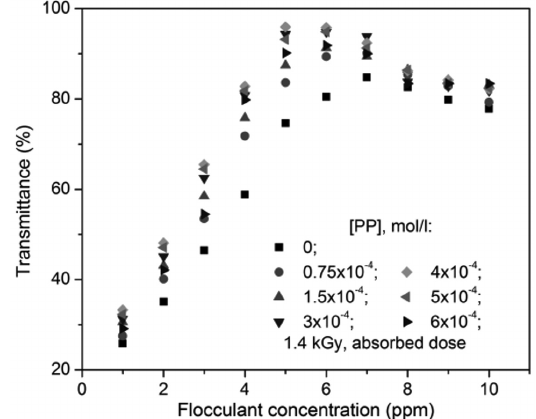
Figure 9. Flocculation performance as a measure of light transmission for different concentrations of flocculants obtained at 1.4